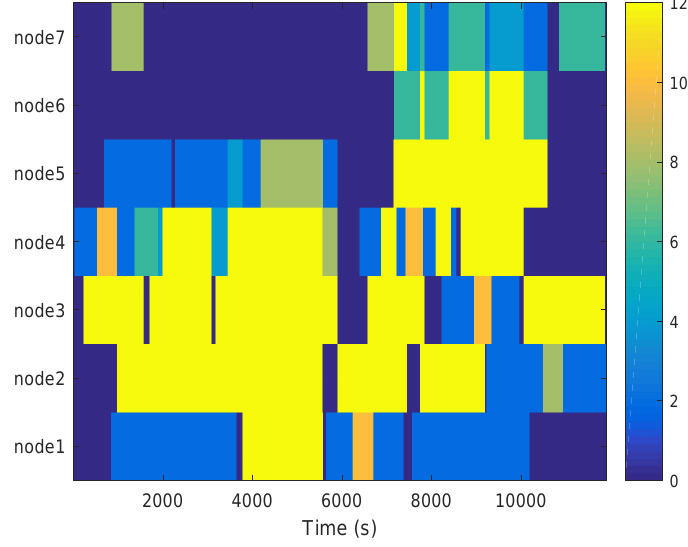
Figure 7. Overall system load for Scenario A using a shared node policy assignment with CLARISSE for avoiding